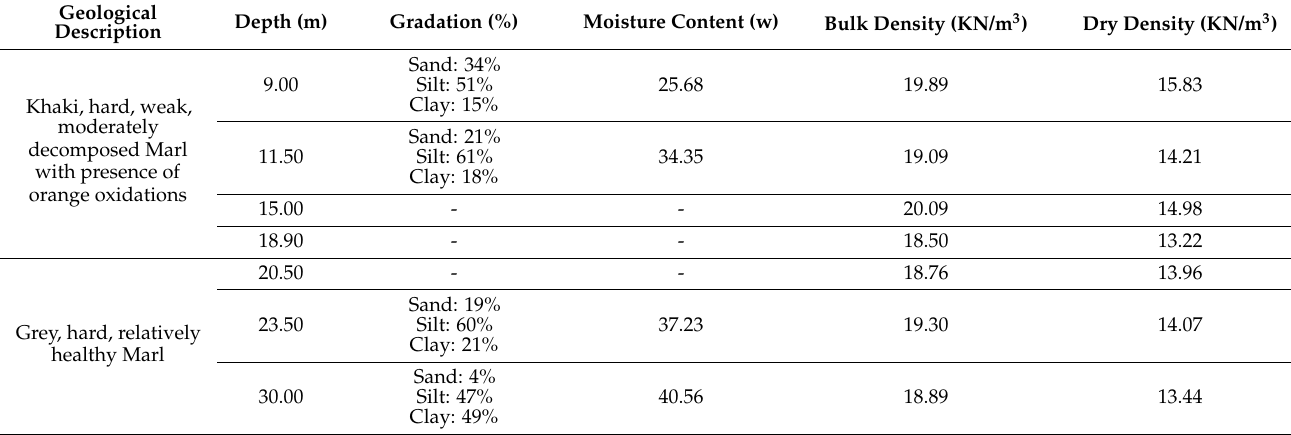
Table 1. Main soil physical and geotechnical characteristics at the area affected by the landslide. Data obtained from borehole investigation carried out by the Geological Survey Department